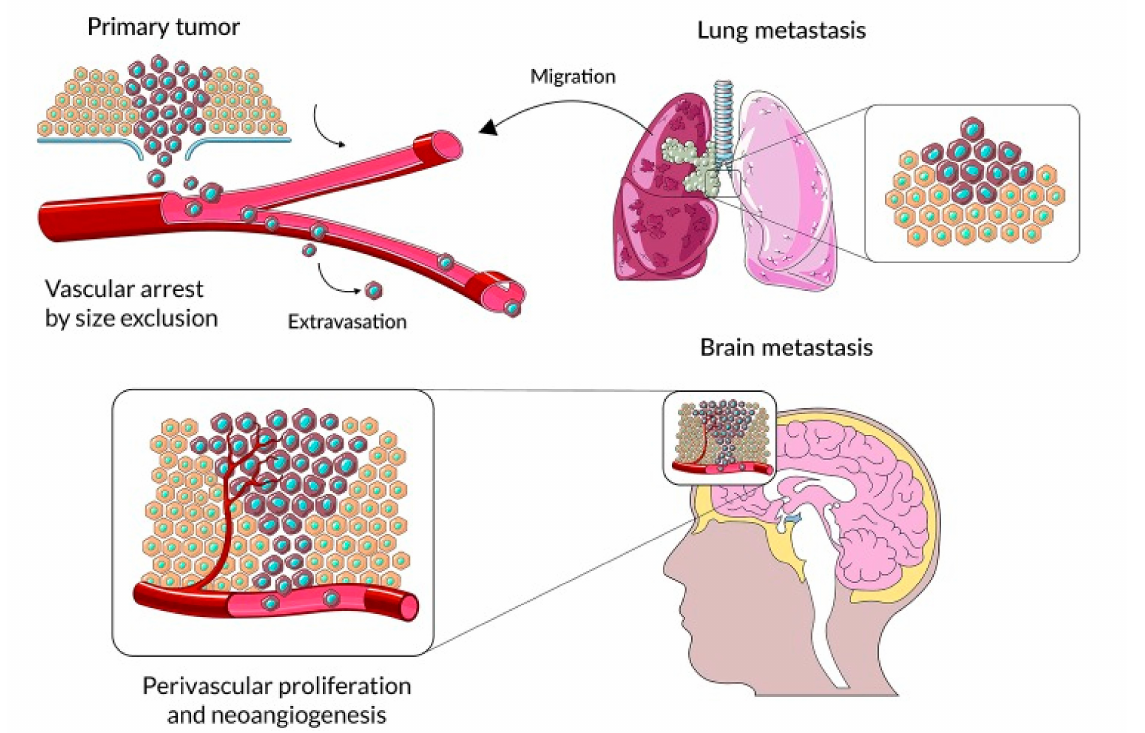
Figure 1. The main stages of cancer cell colonization of brain parenchyma (source: You H. et al., Front Immunol., 2019